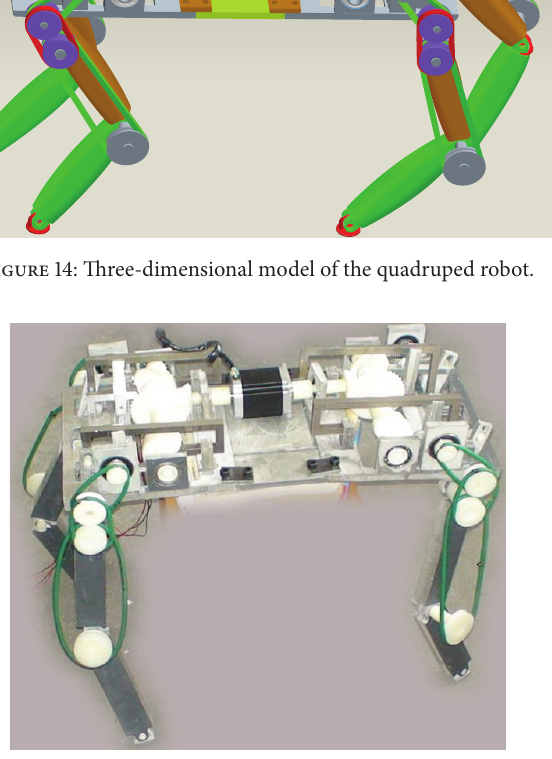
Figure 15: An example quadruped robot